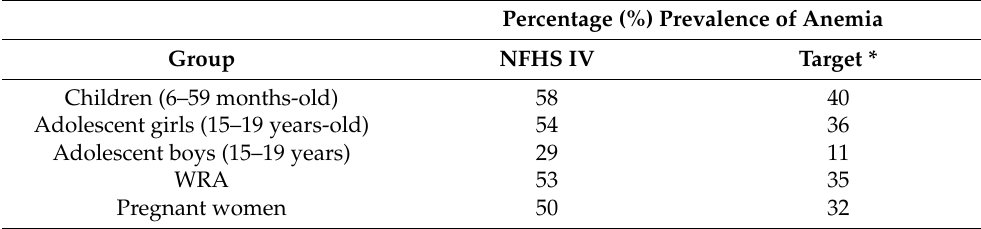
Table 5. Anemia reduction Target for 2022 under Anemia Mukt Bharat 6 × 6 × 6 strategy. WRA, the White Ribbon for Safe Motherhood,